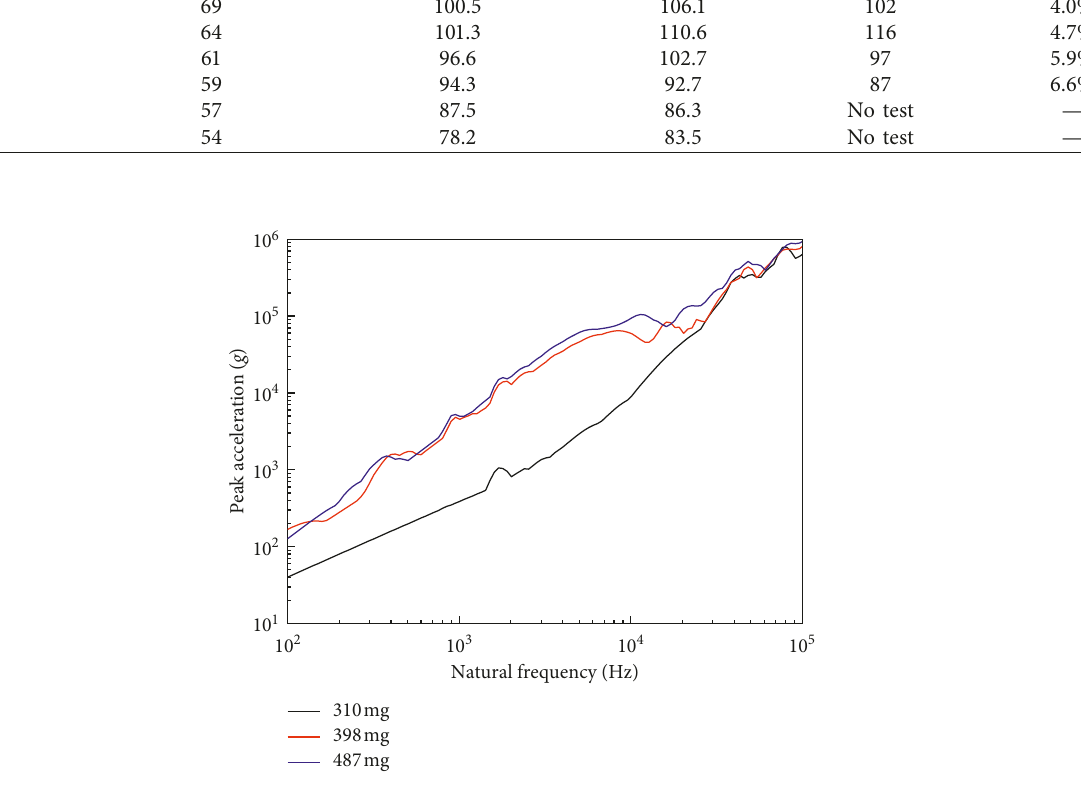
Figure 20: SRS levels at three typical charge amounts.